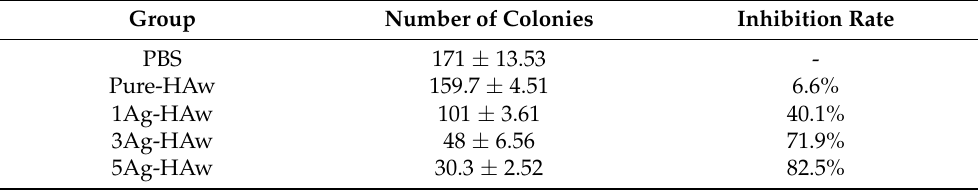
Table 6. Number of S. aureus plate colonies and antibacterial rates in different